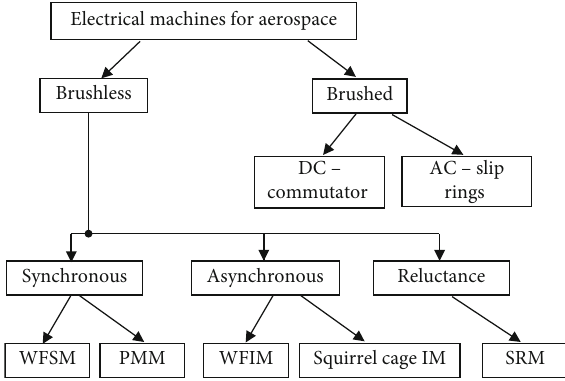
Figure 5: Electrical machines for aerospace